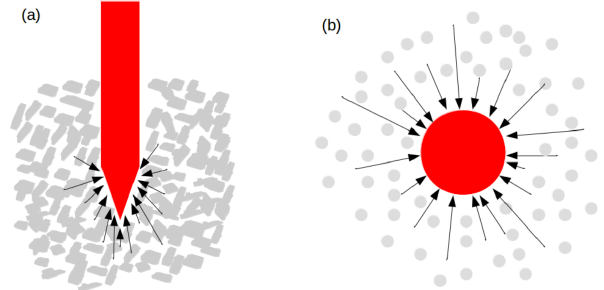
Figure 1. (a) Penetration resistance caused by the interactions of the snow particles (gray) with the penetrometer tip (red); (b) Brown- ian motion where a microscopically visible particle (red) suspended in the fluid is moving randomly due to the collisions with the molecules (gray) in the